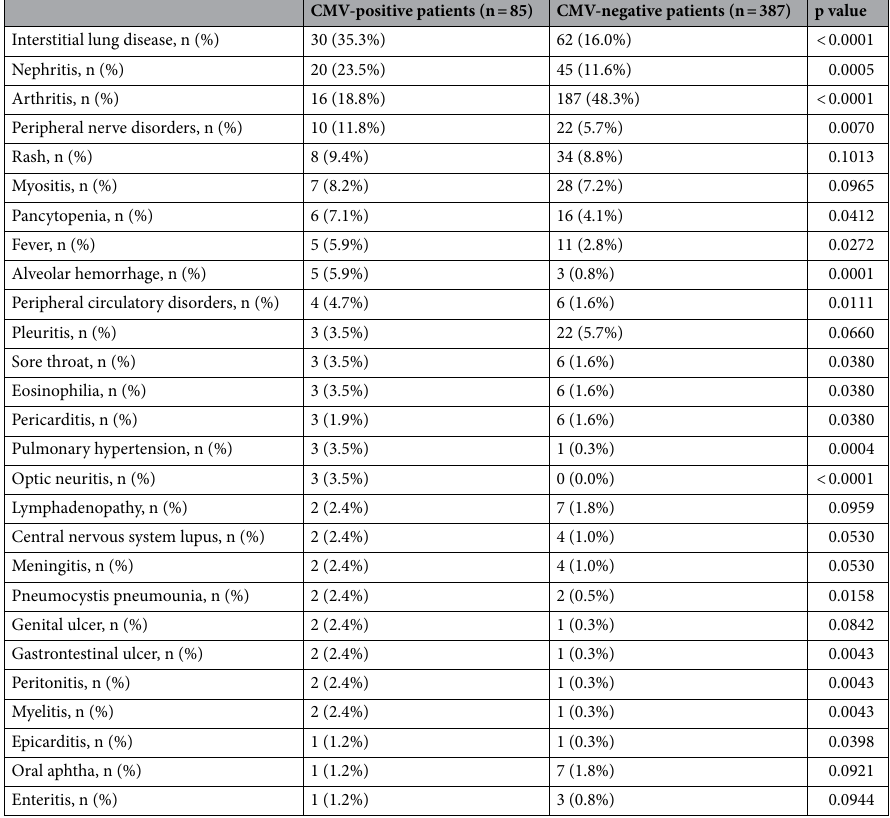
Table 2. Organ involvement of primary problem.